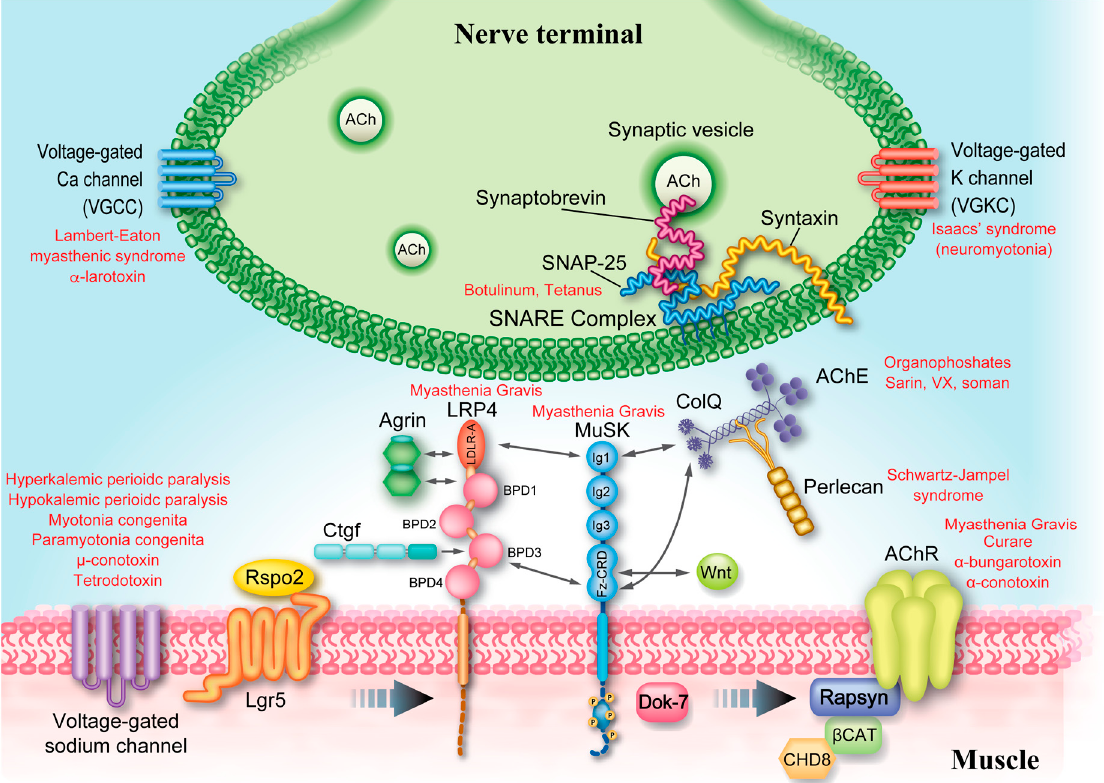
Figure 3. Representative molecules at the nerve terminal and the agrin-LPR4-MuSK signaling pathway to induce AChR clustering. Interactions between binding domains are indicated by double headed arrows [71,98,100–102]. Broken arrows in the muscle indicate that the exact signaling molecules are not shown. Diseases other than CMS and toxins affecting the NMJ are indicated in red letters. β CAT, β -catenin; BPD, β -propeller domain; C6, six-cysteine-box; Ctgf, connective tissue growth factor; Fz-CRD, frizzled-like cysteine-rich domain; Ig, immunoglobulin-like domain; LDLR- A, low-density lipoprotein receptor class A repeat; Lgr5, leucine-rich repeat-containing G-protein coupled receptor 5; and Rspo2, R-spondin 2.